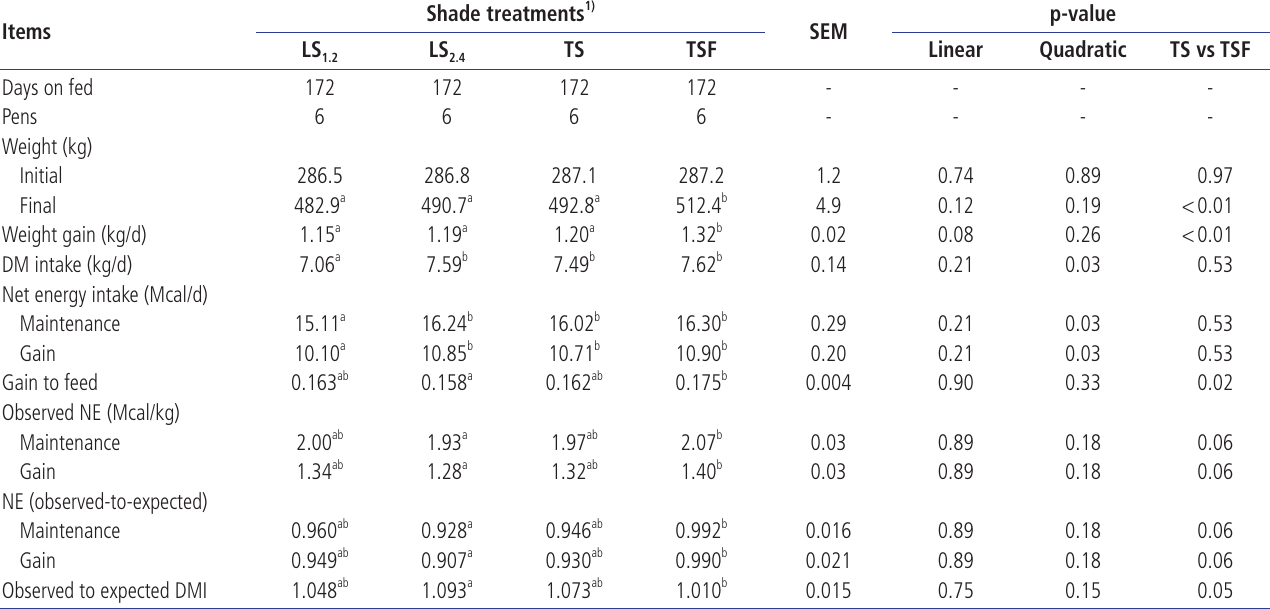
Table 4. Influence of shade treatments on growth performance and dietary energy of feedlot steers